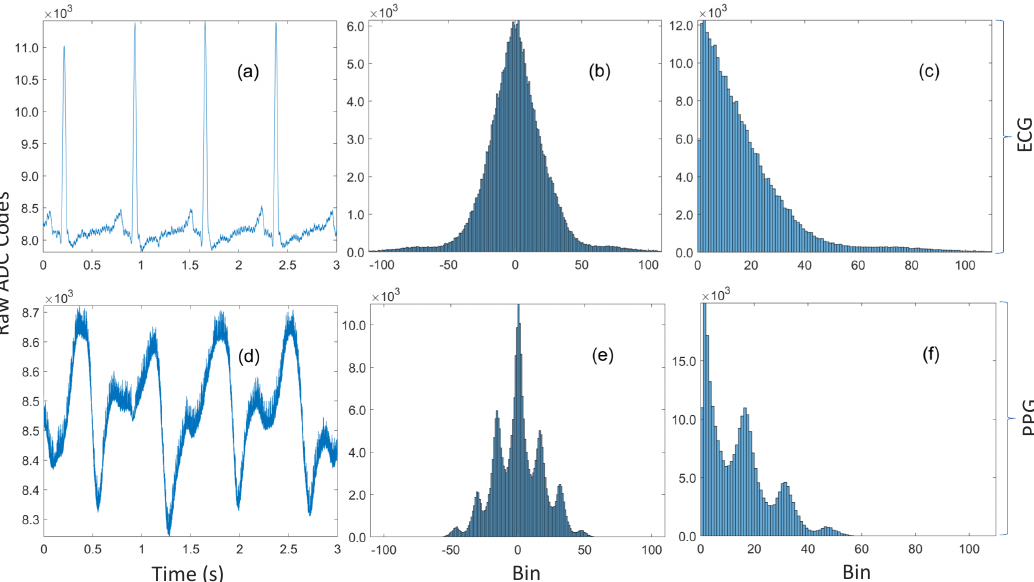
Figure 1. ( a ) A three-second trace of ECG data recorded during device prototyping. ( b ) The unimodal histogram of residuals for the entire ECG dataset with 260k samples. ( c ) The residuals are approximately symmetric, so a sign bit can be transmitted along with the encoded magnitude. ( d ) A three-second trace of noisy rPPG data recorded simultaneously with the ECG. ( e ) The multimodal histogram of residuals for the rPPG. ( f ) The histogram of magnitudes of the residuals for the